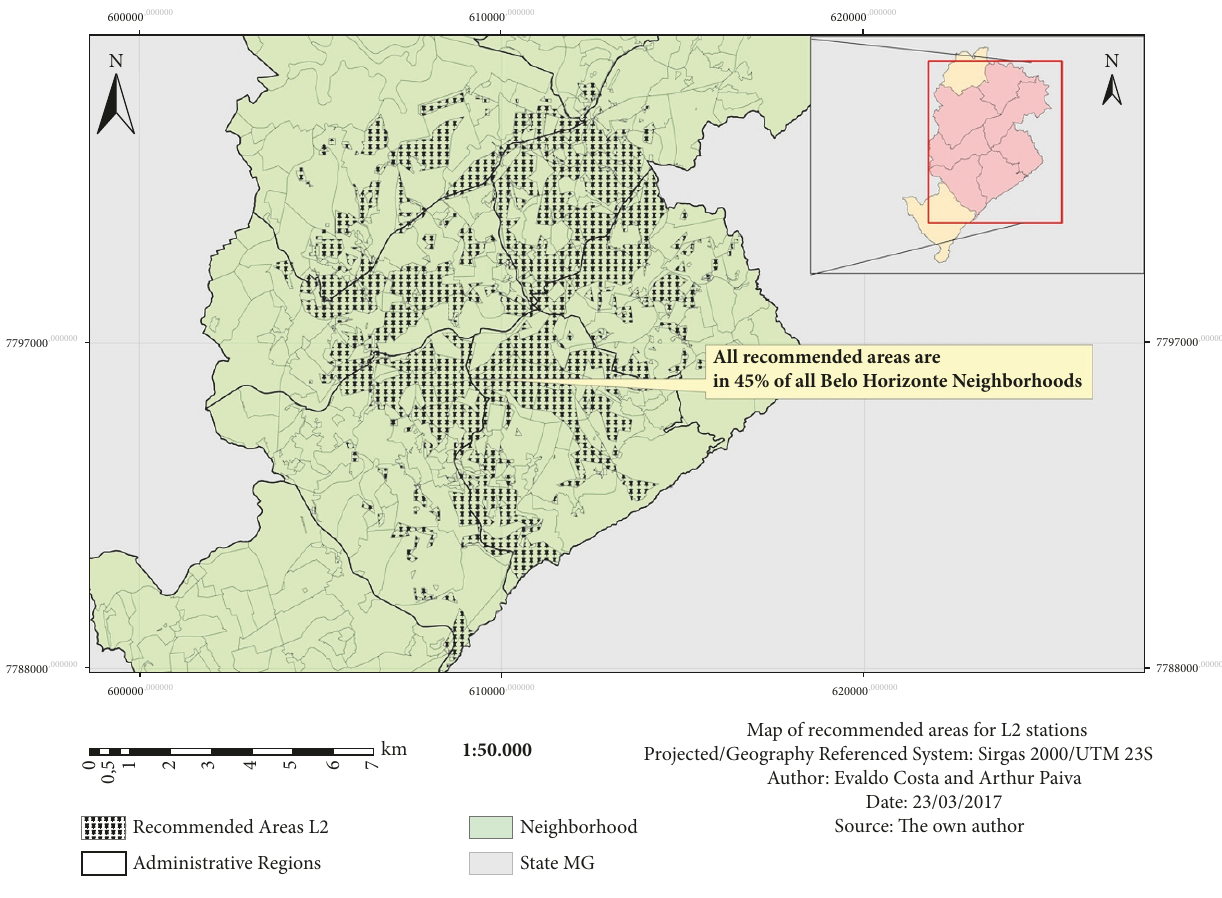
Figure 5: Optimal locations for EVSE